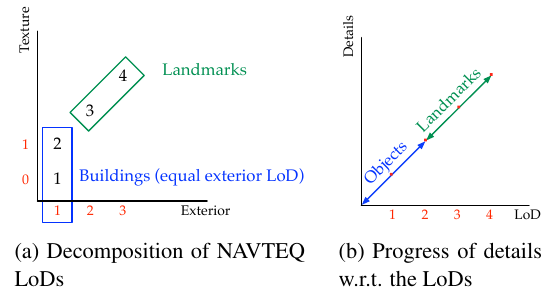
Figure 8: Analysing the four levels of details of the three NAVTEQ 3D